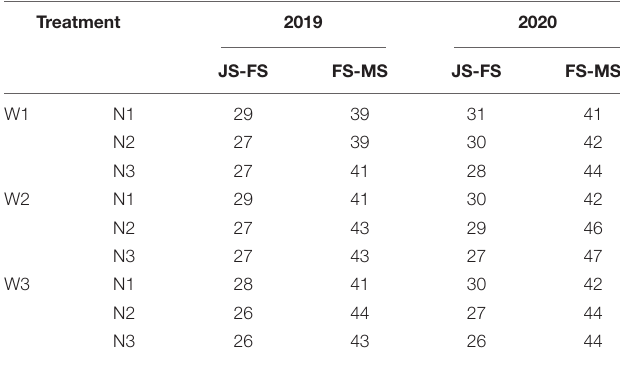
TABLE 3 | Effect of the irrigation methods and N split applications on days of the growth period (d). Treatment